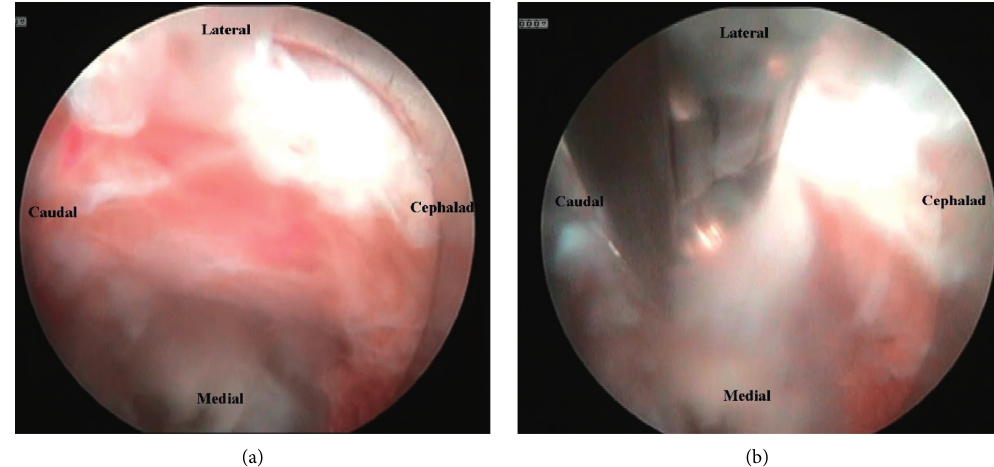
Figure 4: Endoscopic camera views of surgical procedure for the left lumbar 4-5 discectomy. (a) The 30-degree endoscopic camera is in Kambin’s triangle upside down facing the L4 exiting root. The L4 root is demonstrated in this photo with a disc fragment seen below. (b) The endoscopic grasper is shown reaching under the L4 nerve root and removing the large disc